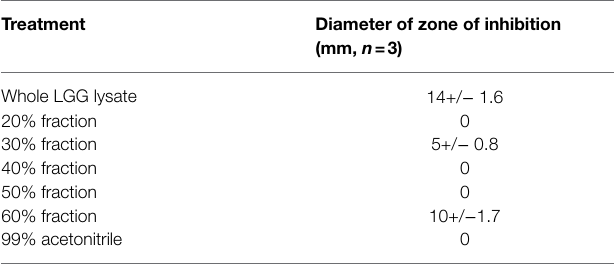
Data shown are the mean and SEM of at least three separate